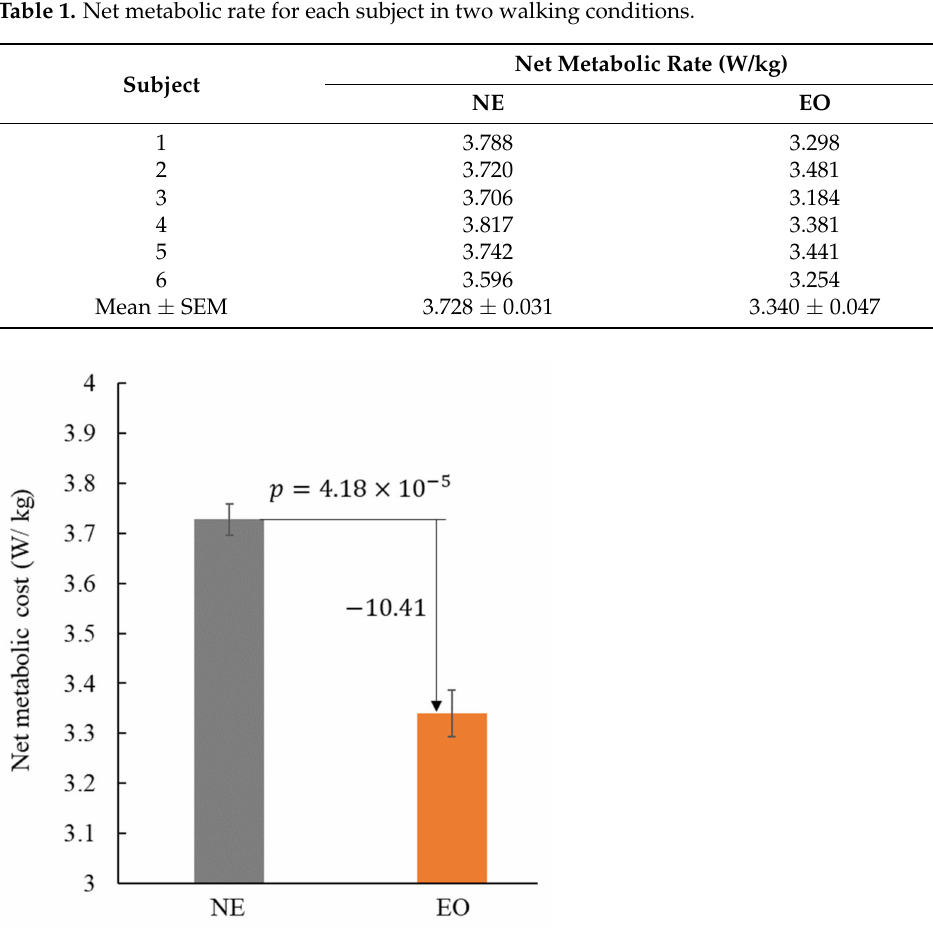
Figure 10. The net metabolic cost of unloaded walking reported in NE and EO